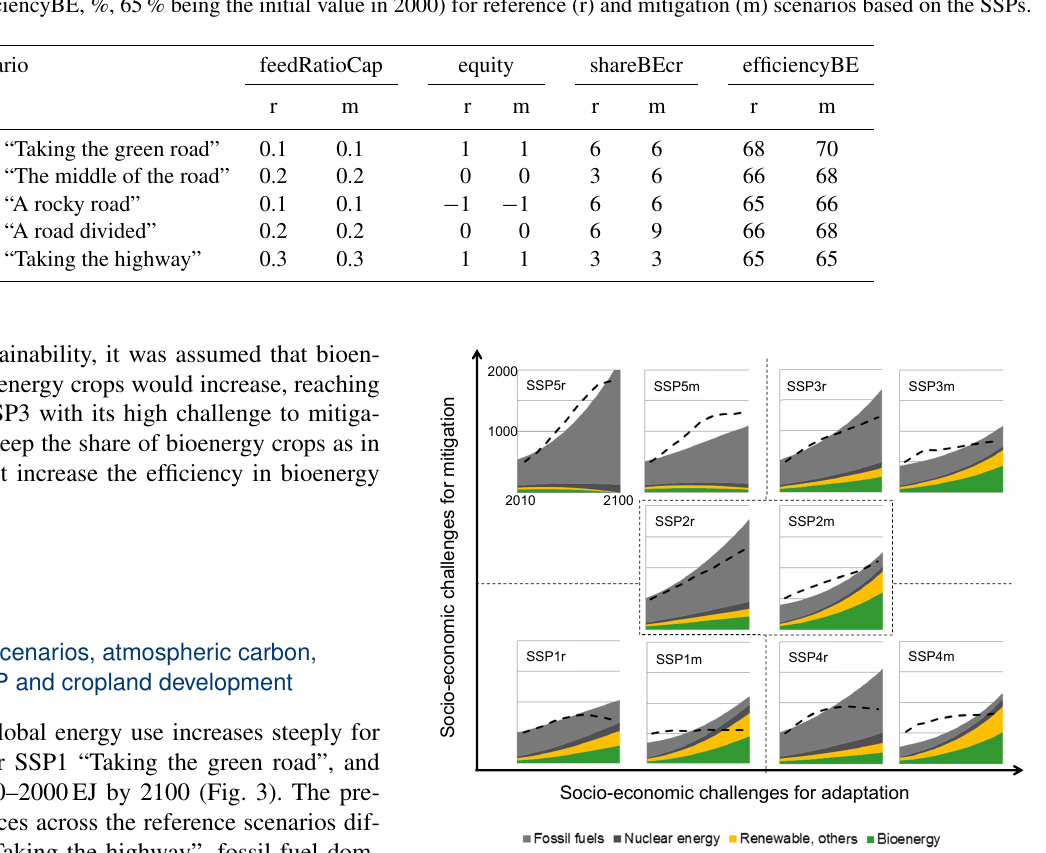
Table 4. Parameter settings in the PLUM land use model for feedRatioCap (0.1–0.3: feed ratio increases for countries with feed ratios